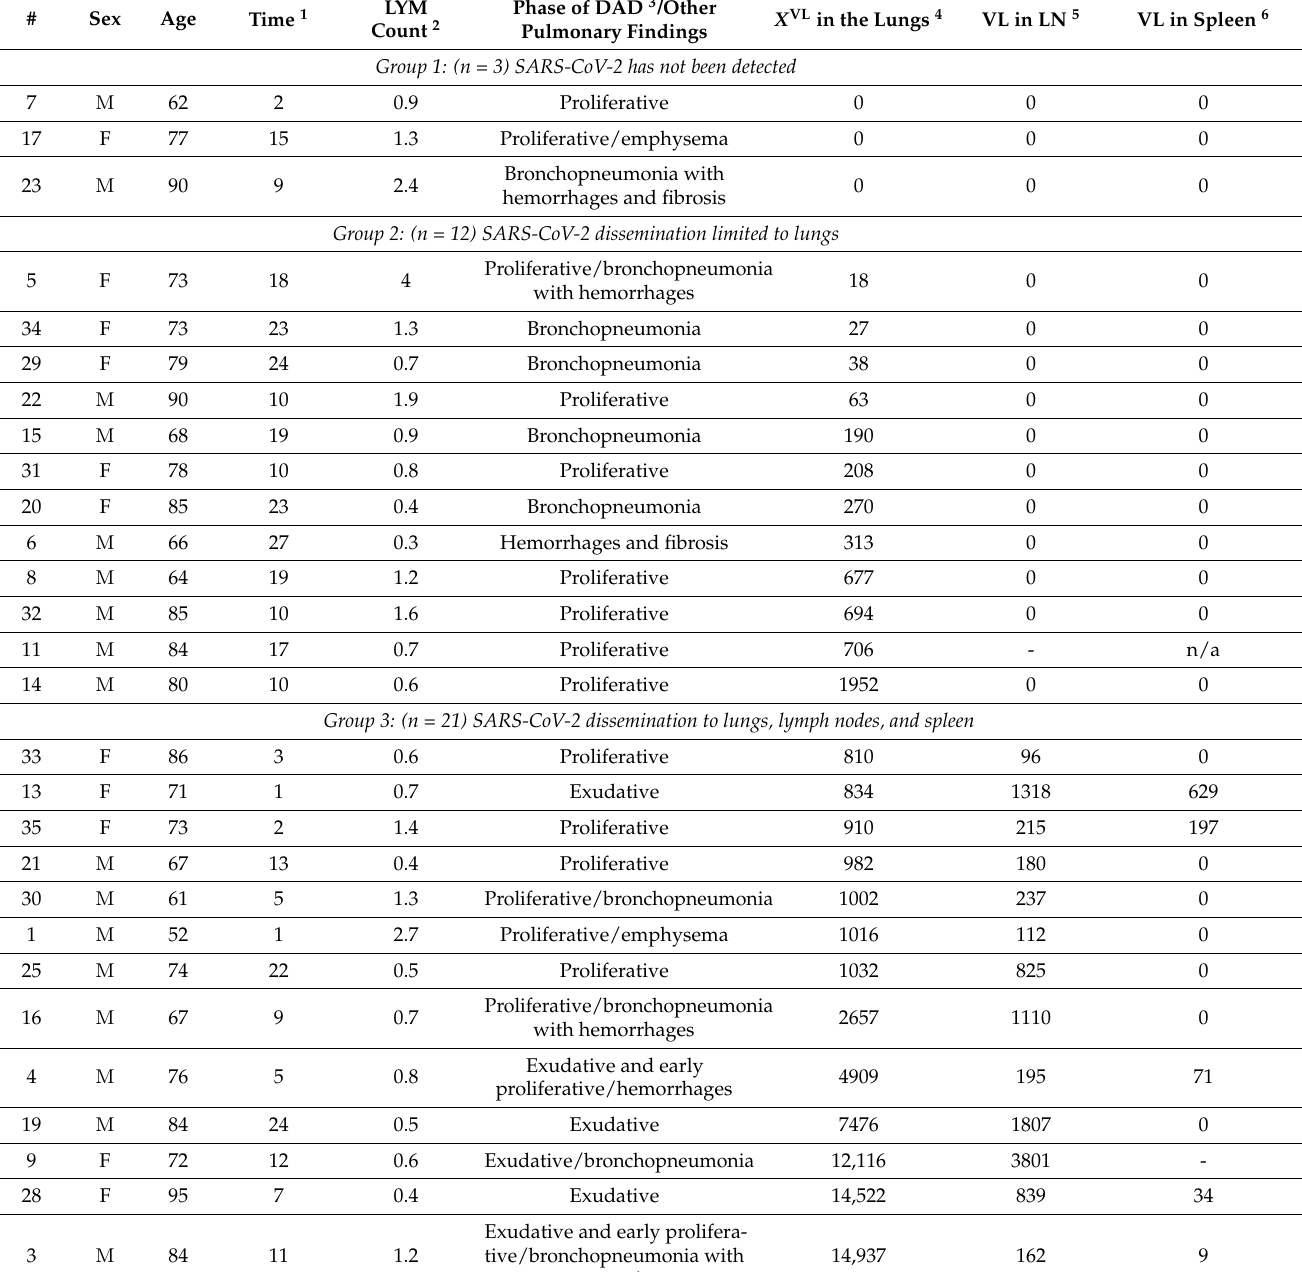
Table 1. General characteristics of patients and SARS-CoV-2 VL in lung, lymph node, and spleen